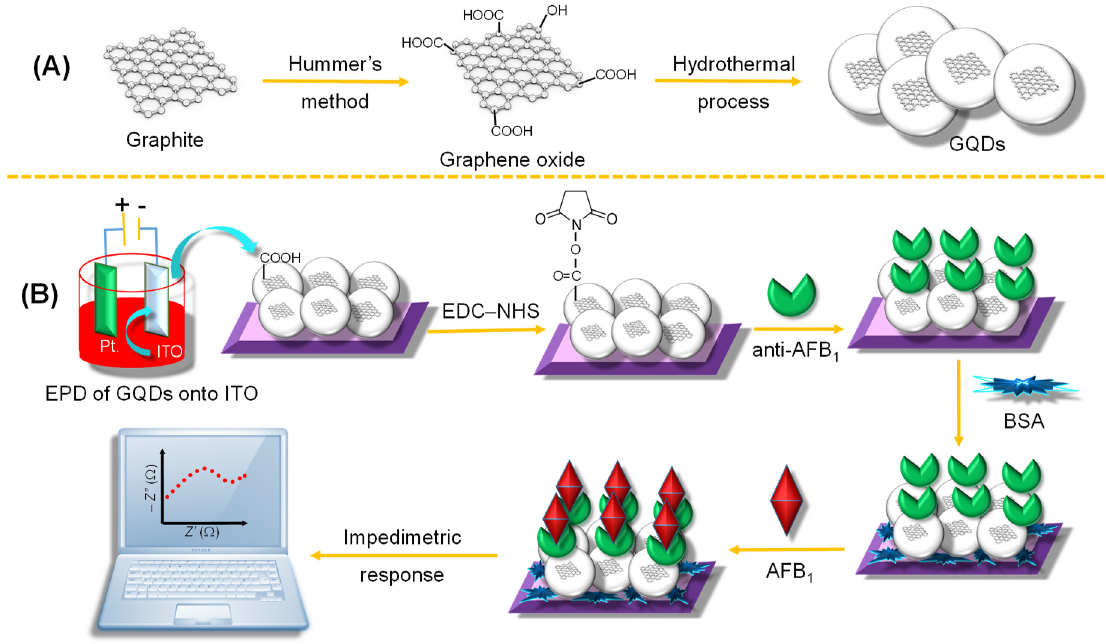
Figure 25. ( A ) Preparation of GQDs. ( B ) Immunosensing platform for AFB 1 using GQD-functionalized indium tin oxide (ITO)-coated glass electrode [79].